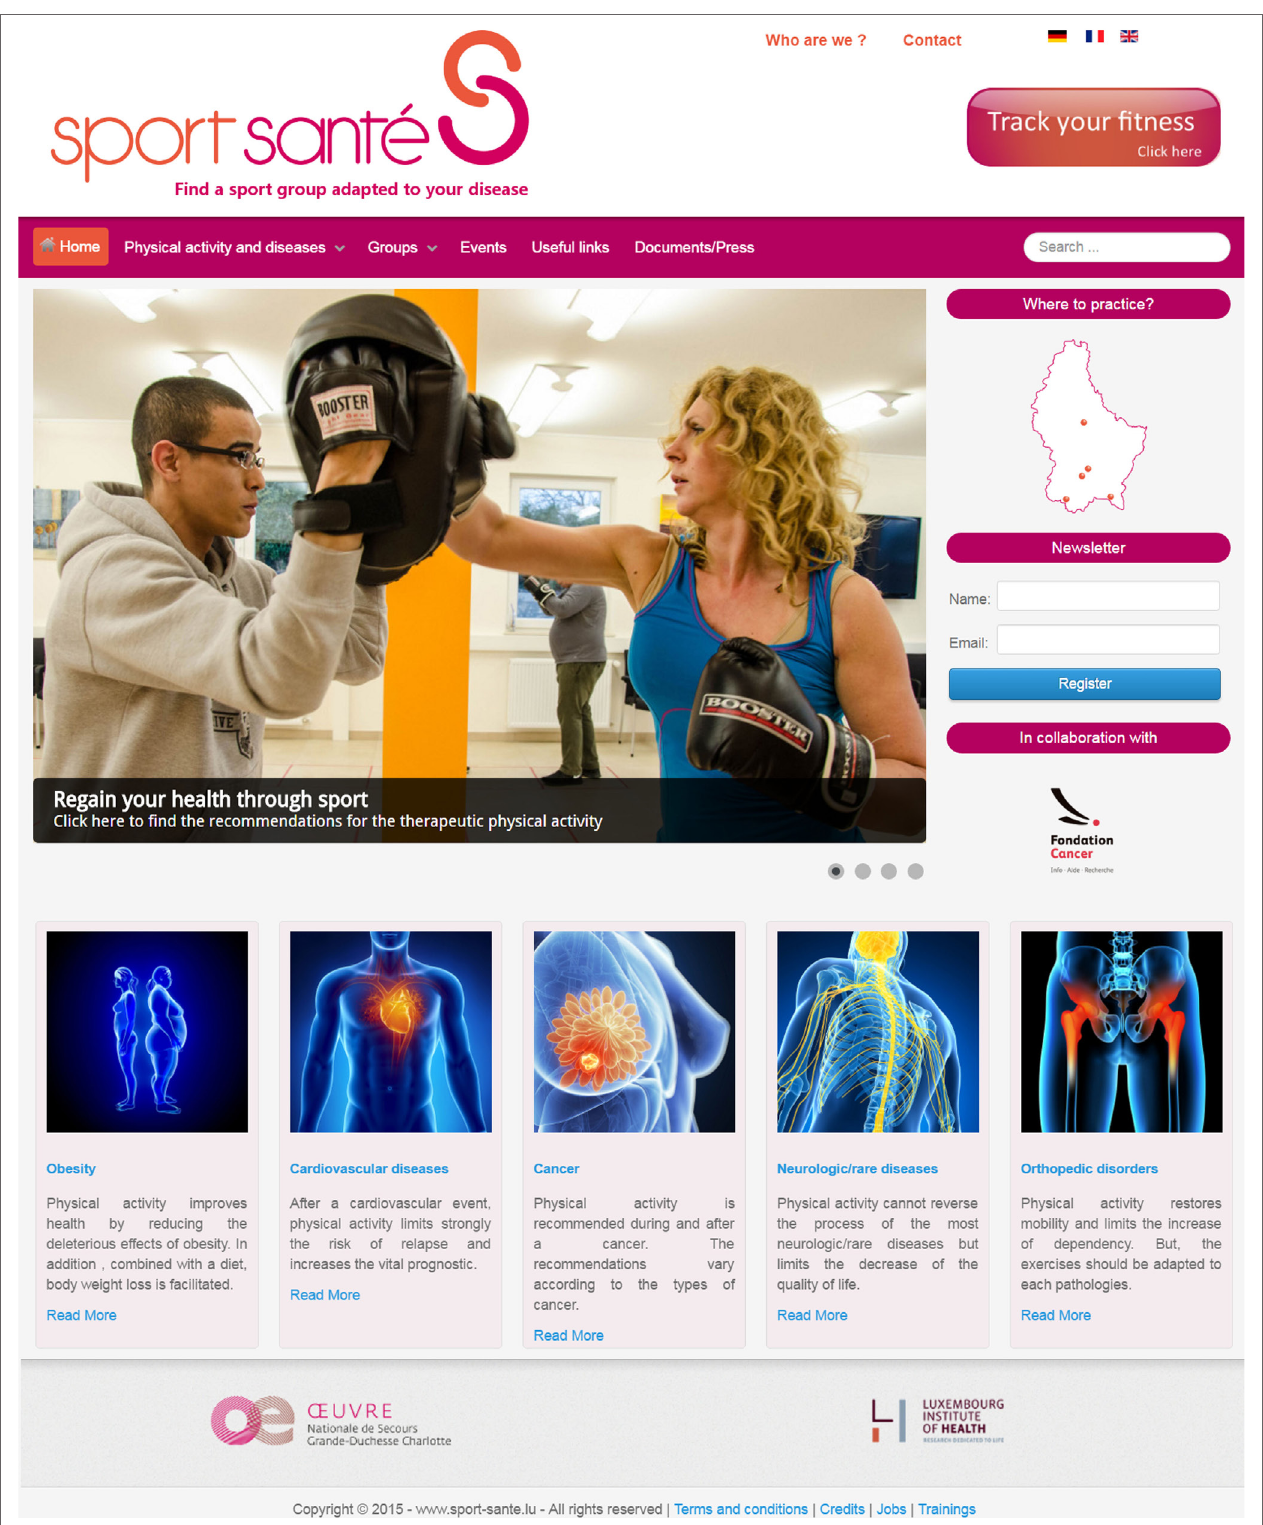
FigUre 1 | screenshot of the sport-santé homepage (www.sport-sante.lu) . While the local offer of therapeutic physical activity is available within the “Groups” section and located on the map, the theoretical factsheets can be found in the “Physical activity and diseases” section. The homepage contains also links to the events and the Sport-Santé documents. With the kind permission of the Oeuvre Nationale de Secours Grande-Duchesse Charlotte.